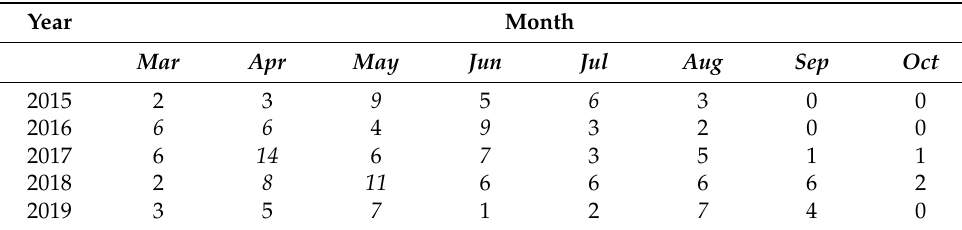
Table 1. Frequency of sea breeze occurrence as observed using radar categorized by month and year. The two months in each year with the highest frequency are italicized; 2016 has three months italicized because March and April each had 6 observed sea breezes.